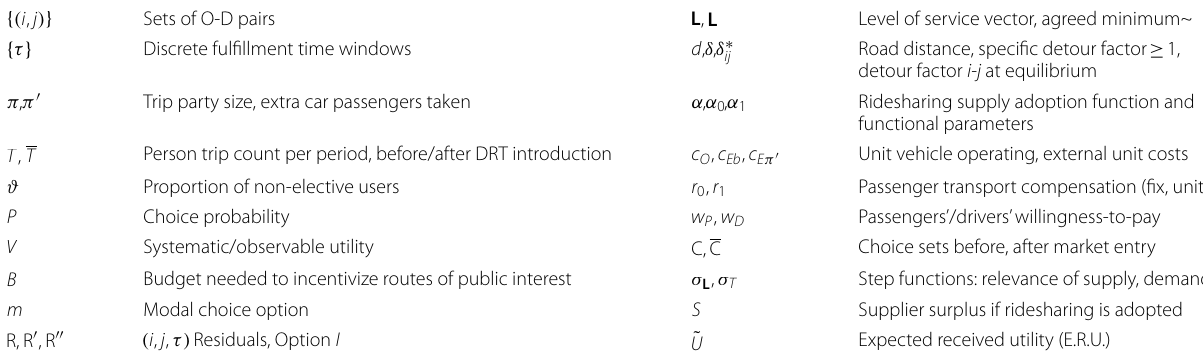
Table 2 Key to symbols